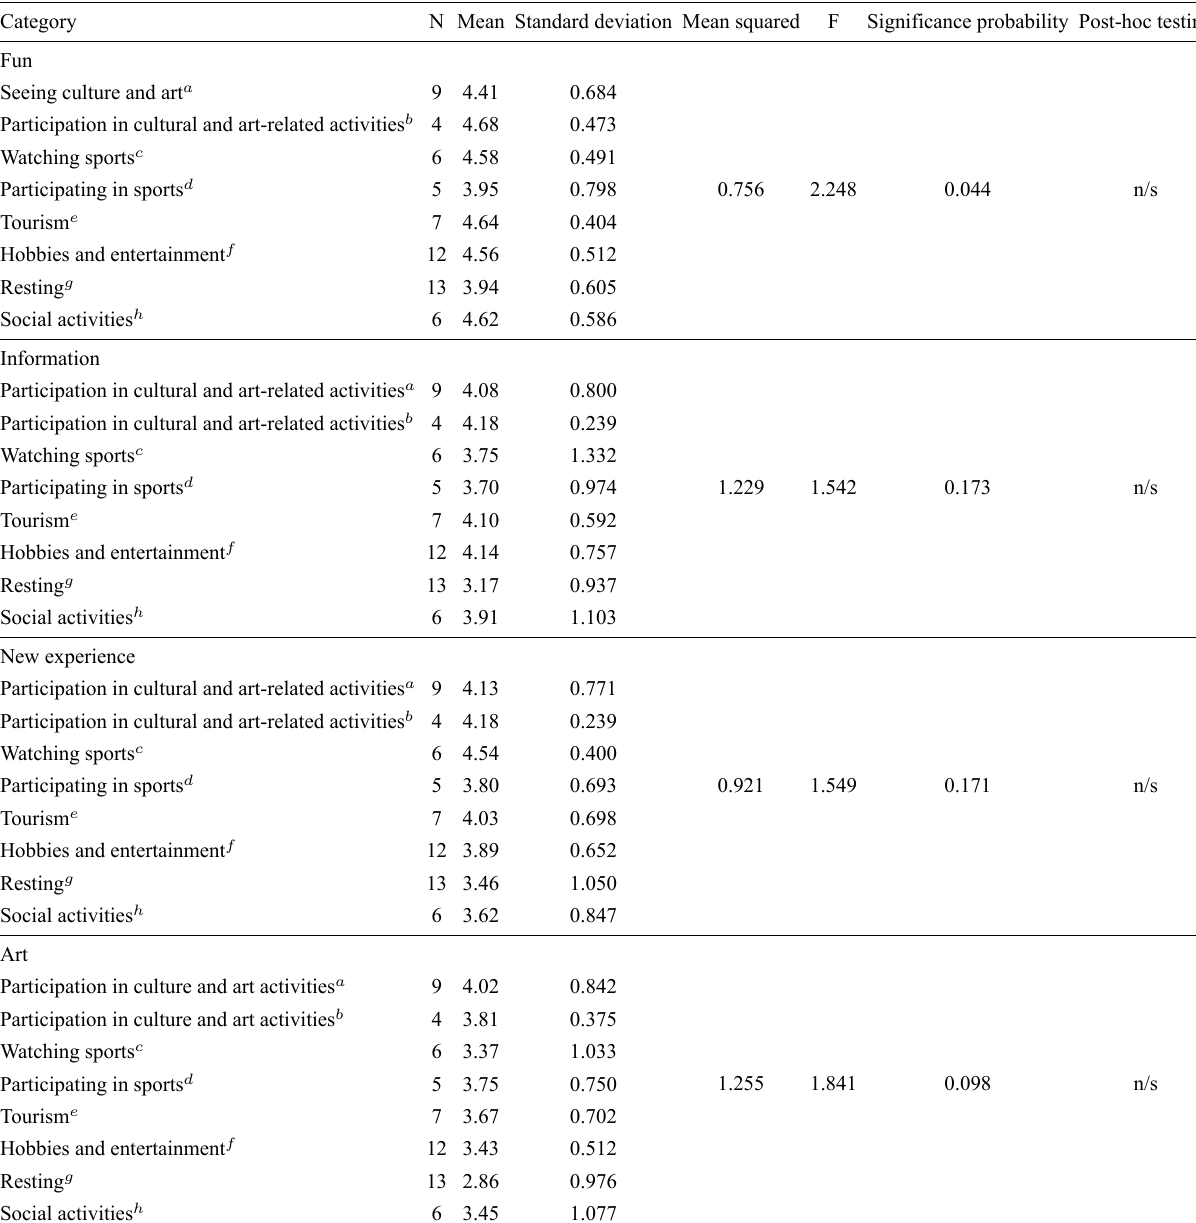
Table 4. Differences in leisure activities for healthy group (n =